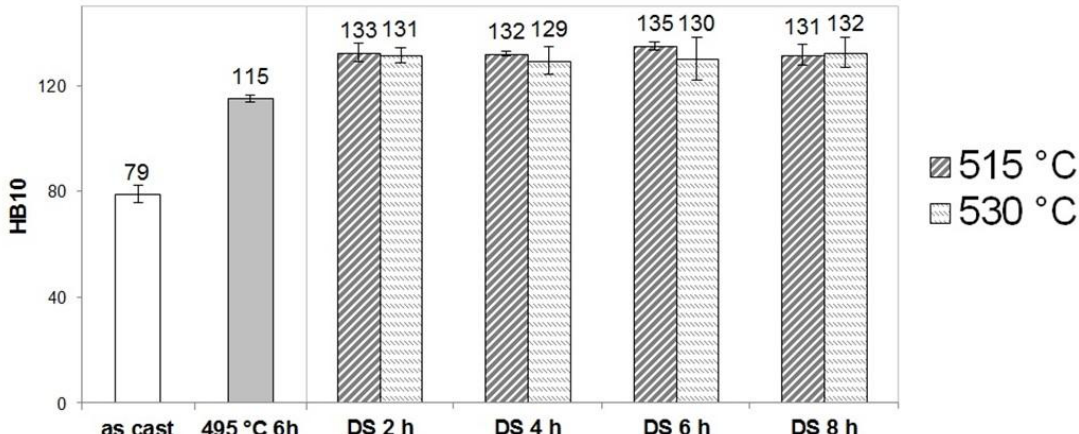
Figure 8. Hardness of A354 alloy in the as-cast condition, after solution treatment at 495 °C–6h, and after Double Stage (DS) solution at 495 °C–6 h + 515/530 °C–2/8 h, which is followed by hot water quenching (60 °C) and artificial aging at 200 °C–2 h. This is readapted from Reference